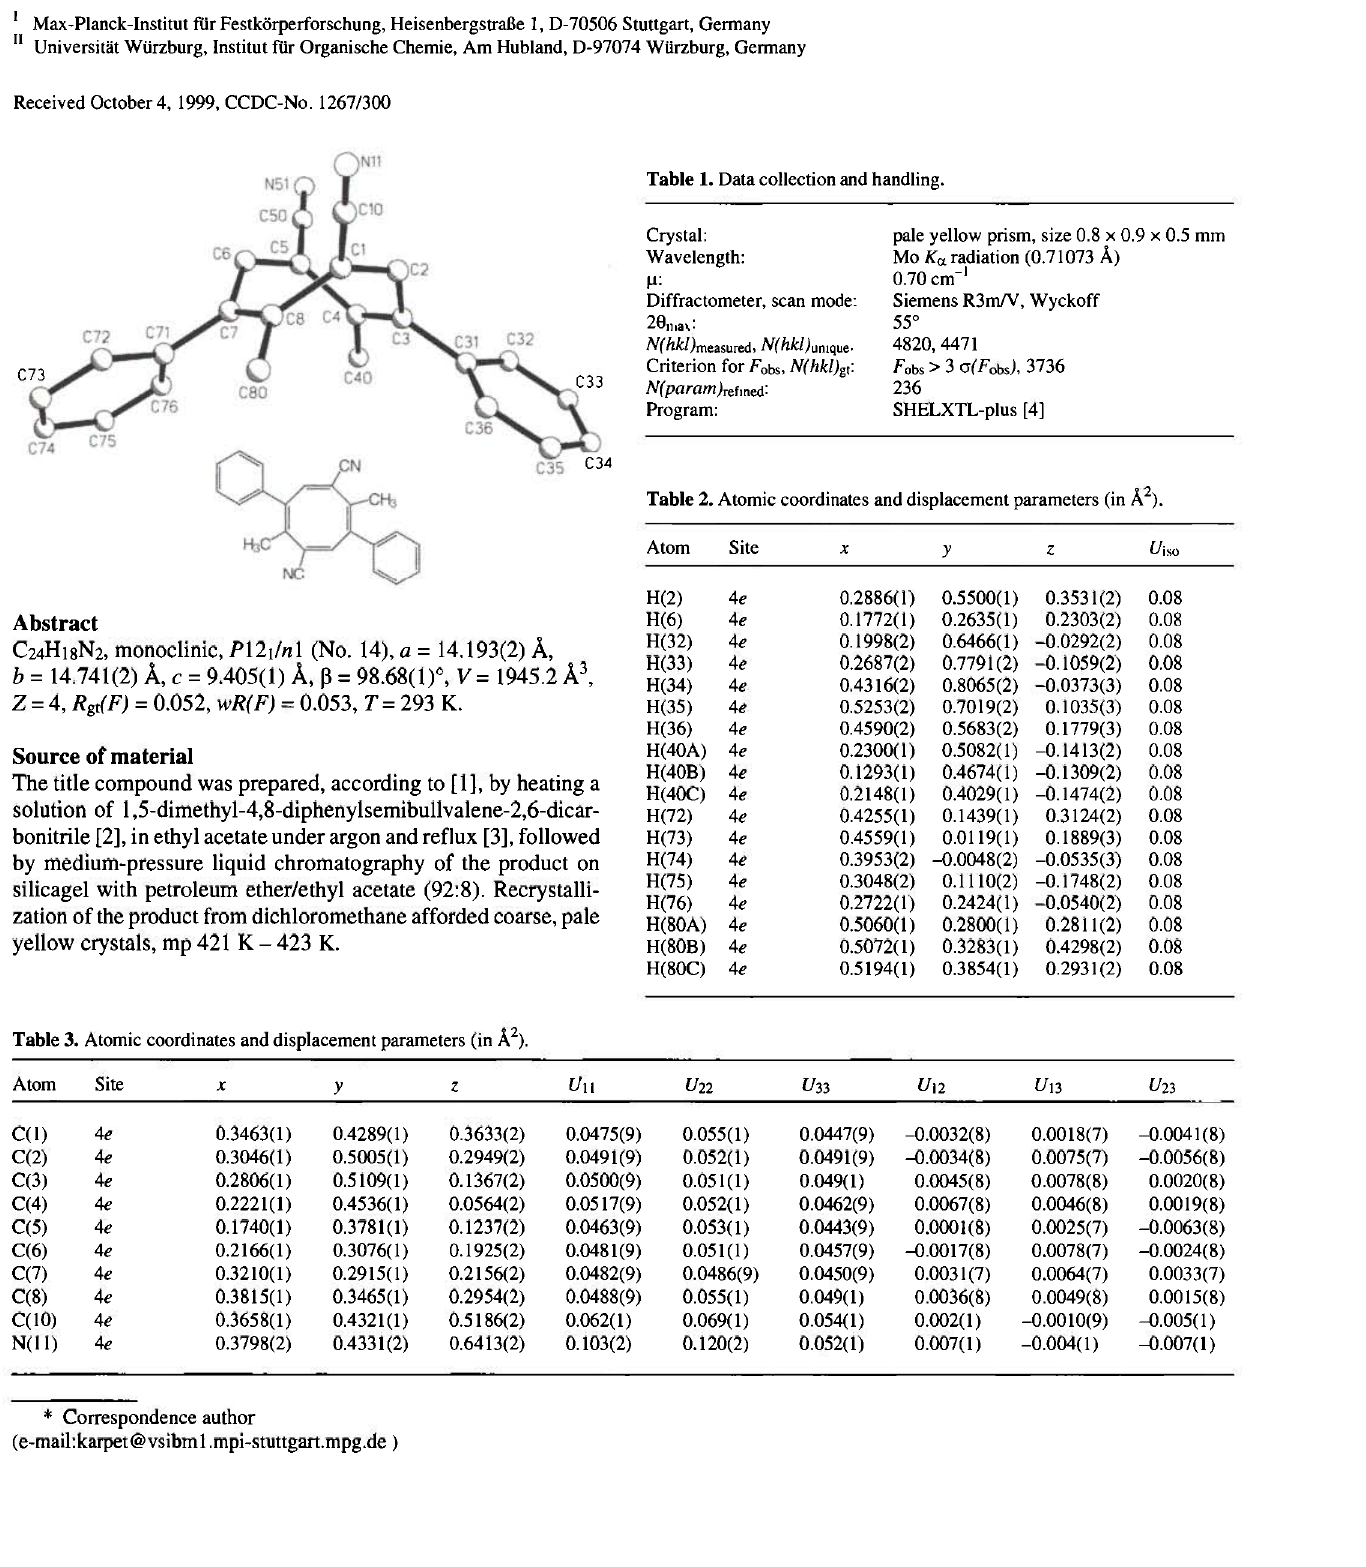
Table 2. Atomic coordinates and displacement parameters (in Ä 2